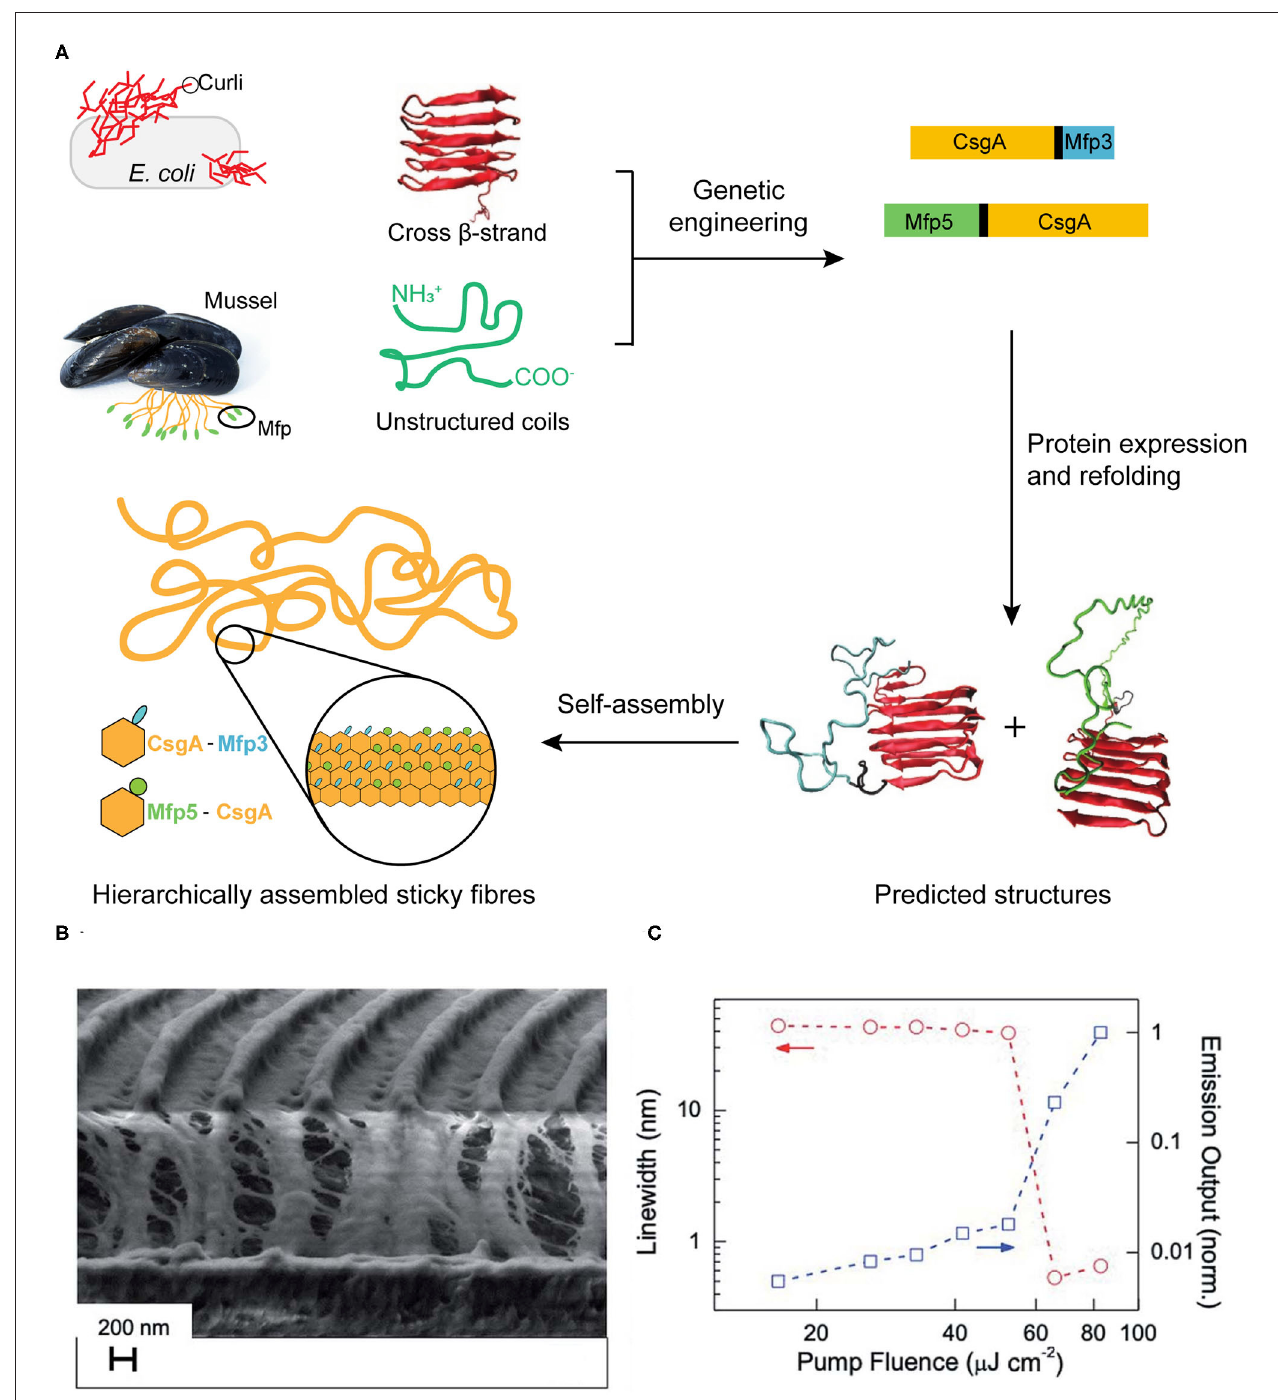
FIGURE 9 | Protein assemblies for bio-mechanical (A) and bio-optical applications (B,C) . (A) Scheme of combinatorial and modular genetic strategy for designing self-assembling underwater adhesives. (B,C) Engineered CTPR-based functional nanopatterned materials for bio-optical devices. (B) Scanning electron microscope image (vertical cut) of nanostructured CTPR-Rh6G on top of IPS ® with 416nm periodicity. (C) Log-log plot of the PL linewidth (left Y -axis, circles, indicated by red arrows) and emission output (right Y -axis, squares, indicated by blue arrows) normalized by the output at the highest fluence as a function of excitation fluence. Reprinted with permission from Sanchez-deAlcazar et al. (2019). Copyright 2019 Royal Society of Chemistry.